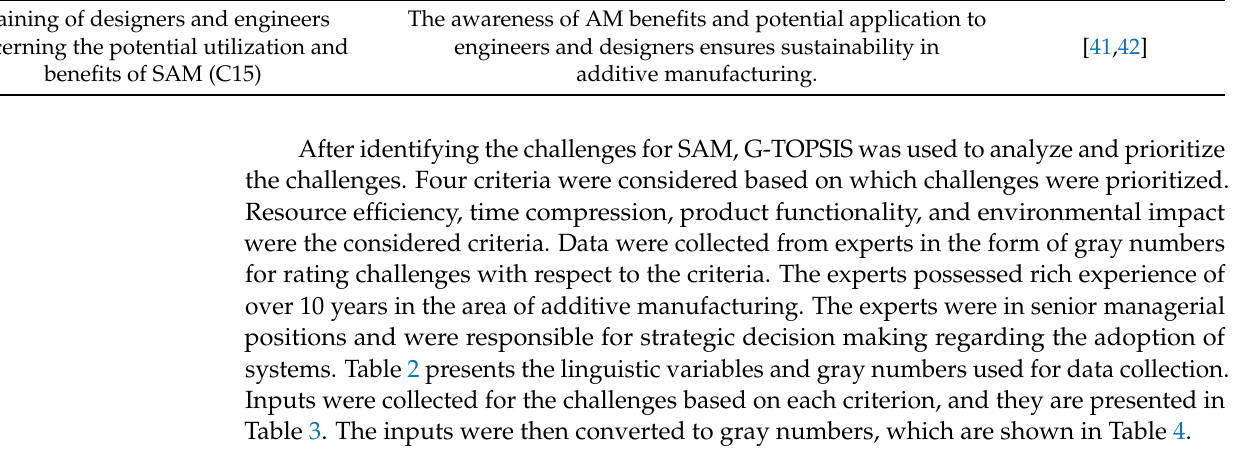
Table 2. Linguistic variables and gray numbers used for challenge ratings.